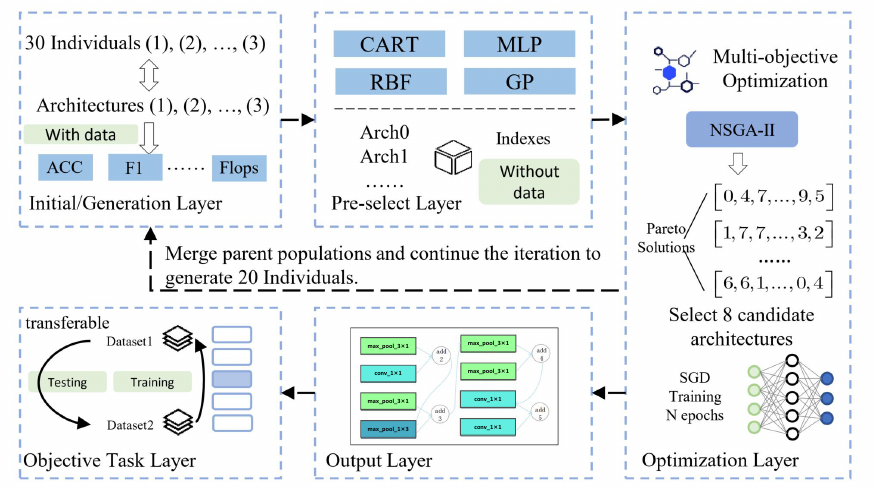
Figure 3. The detailed approach and experiment description for